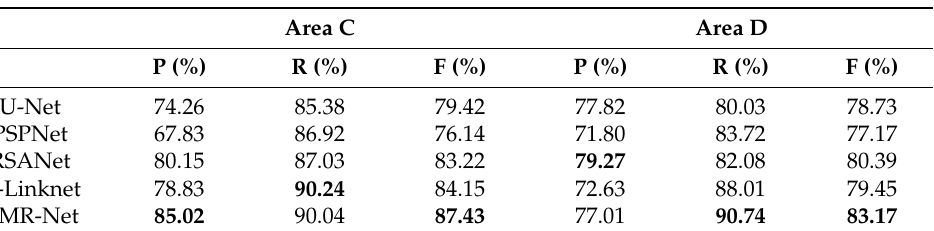
Table 7. A results comparison between the GMR-Net method and other methods in research areas E and F, where the values shown in bold are the best.